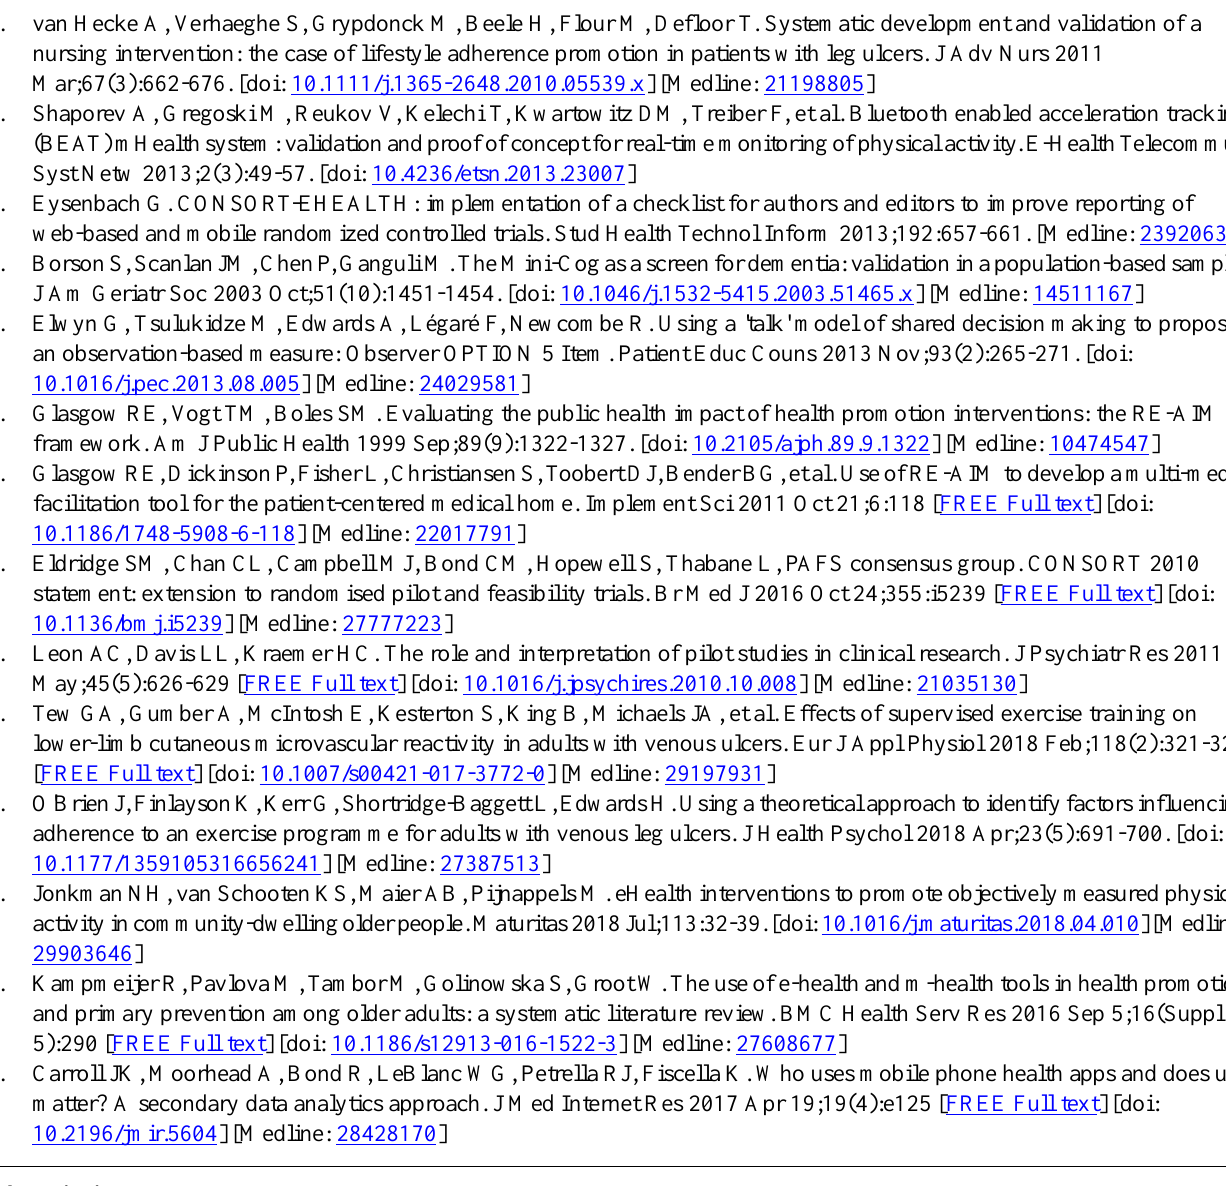
BEAT: Bluetooth-enabled acceleration tracking CALF: conditioning activities for lower leg